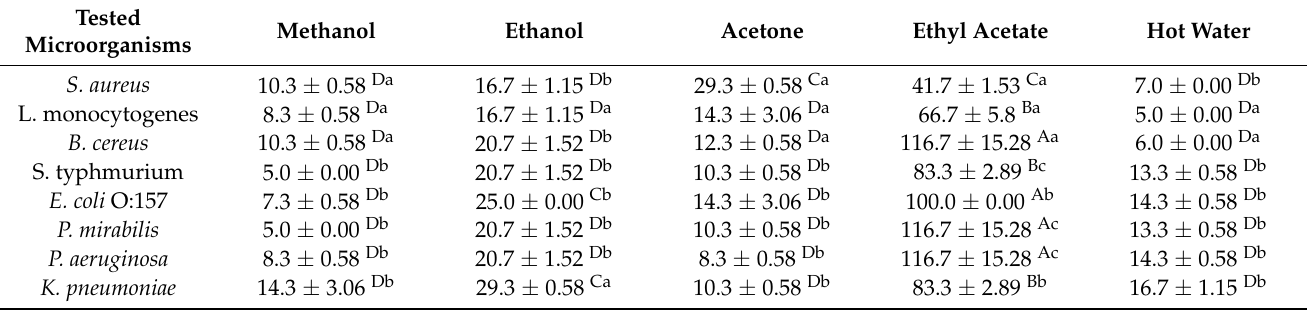
Table 9. Minimal inhibitory concentration (MIC) values of P. guajava leaves